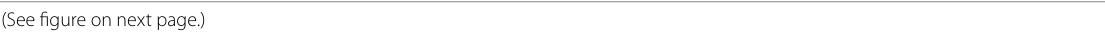
Fig. 6 Inhibiting TANK blocks NF‑κB signalling and rescues LPS‑induced mitochondrial dysfunction, apoptosis and high permeability in Caco‑2 cells. Caco‑2 cells were transiently transfected with TANK‑specific siRNA or control siRNA for 24 h and then treated with LPS (50 μg/mL) for 24 h. A The location of NF‑κB was examined after the indicated treatments. NF‑κB is stained green; the nuclei are stained blue. The scale bar represents 20 μm. B Representative Western blots showing the indicated proteins in the NF‑κB pathway are on the left, and the graph on the right shows the relative band densities. C Morphological alterations in mitochondria were examined by TEM (scale bar relatively normal mitochondrial shape in the sham group. Red arrows denote deformed mitochondria with the loss of clearly defined cristae. Green arrows indicate the rescued mitochondrial shape. D The relative fluorescence intensity of ROS in the Caco‑2 cells. E The ratio of JC‑1 red/ green fluorescence intensity which reflecting the MMP level was shown in graph. F Representative Western blots showing mitochondrial fusion (Mfn1, Mfn2, OPA1) and fission (Drp1 and Fis1) markers on the left, and the graph on the right shows the relative band densities. G Apoptosis was analysed by Annexin V‑FITC/7‑AAD double‑labelling assays. The graph shows the proportion of apoptotic cells. H The levels of apoptotic markers were measured by Western blots. The graph shows the relative band densities. I The levels of ZO‑1 and Occludin were analysed by Western blotting. The graph shows the relative band densities. J TEER levels in each group. The data in the graphs are expressed as the mean replicated in three independent experiments. ** P < 0.01, *** P